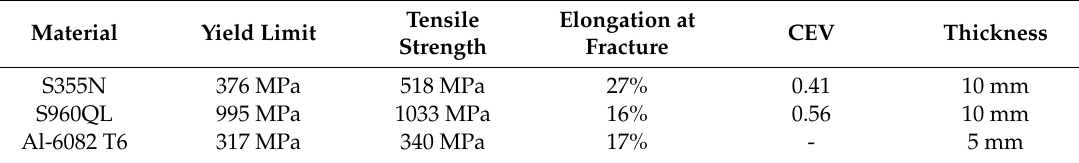
Table 1. Base metals used for specimen preparation: mechanical and chemical parameters determined by tensile test respectively spectroscopy.